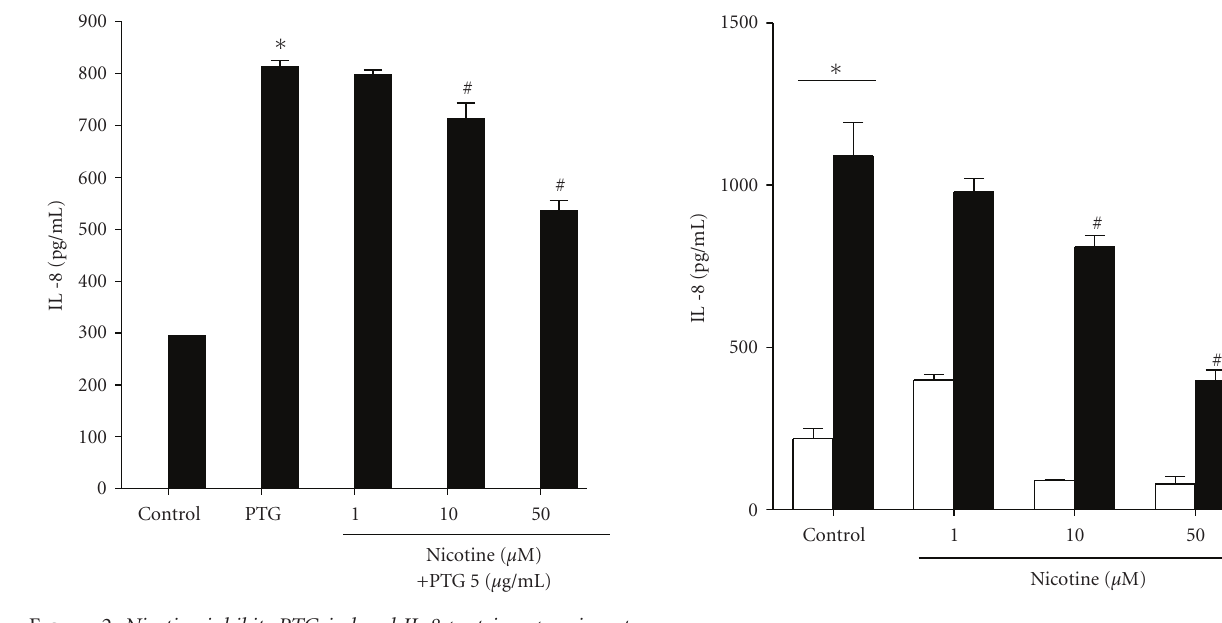
Figure 2: Nicotine inhibits PTG-induced IL-8 protein expression at concentrations of 10 and 50 μ M. CFTE29o- cells (1 × 10 5 /mL) were stimulated with increasing doses of nicotine (0–50 μ M) for 1 hour. These samples were left untreated (control) or treated with PTG (5 μ g/mL, 24 hours) as indicated. Levels of IL-8 in supernatants were measured by ELISA. Assays were performed in triplicate ( ∗ and # P ≤ . 05, ∗ versus control, # versus PTG) ( n = 6).